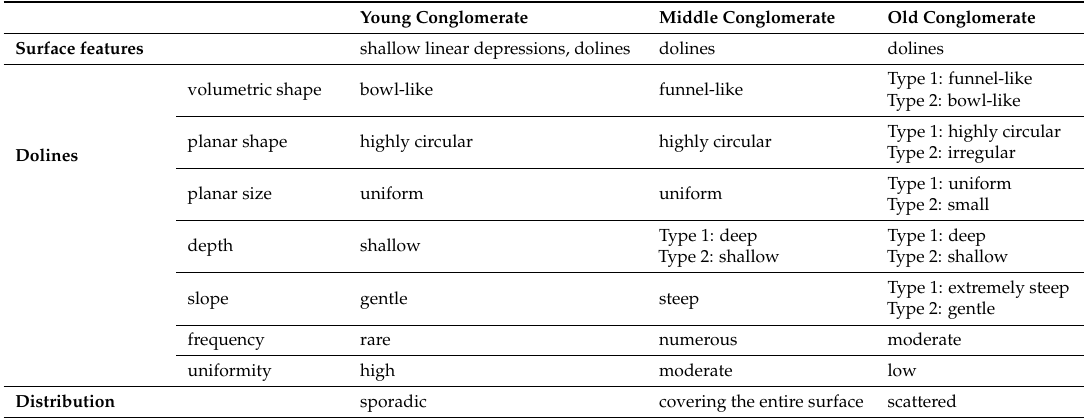
Table 5. Descriptive morphometrical and distributive characteristics of dolines for karstified conglomerates by